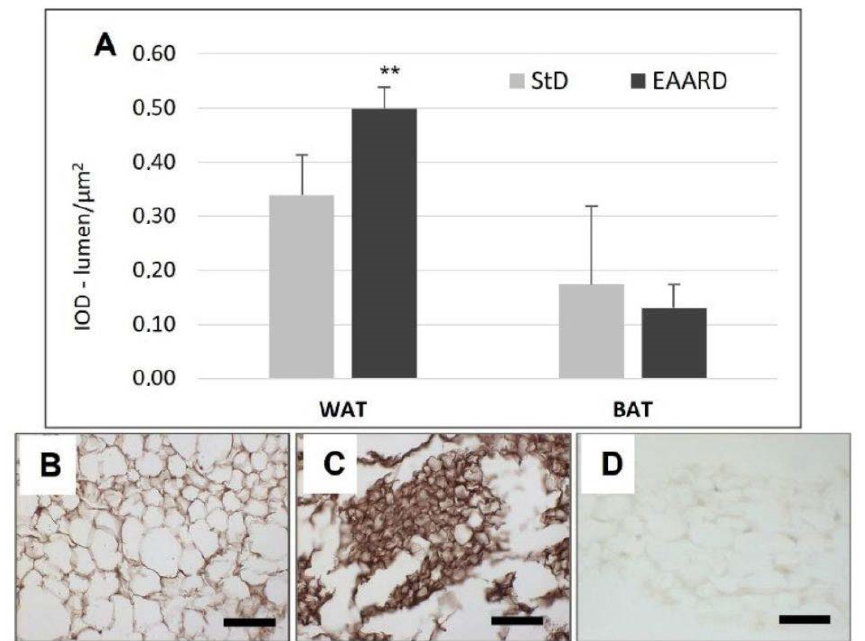
Figure 4. ( A ): Optical density for adiponectin immunostaining in rpWAT ( t = 2.779, p = 0.01) and BAT ( t = 2.069, p = 0.08) according to diets (mean ± sd). ** p < 0.01. ( B , C ): Representative images of rpWAT IHC in StD and EAARD-fed mice, respectively. ( D ): Negative control performed by omitting the primary antibody. Original magnification 20×; scale bar 50 μm.